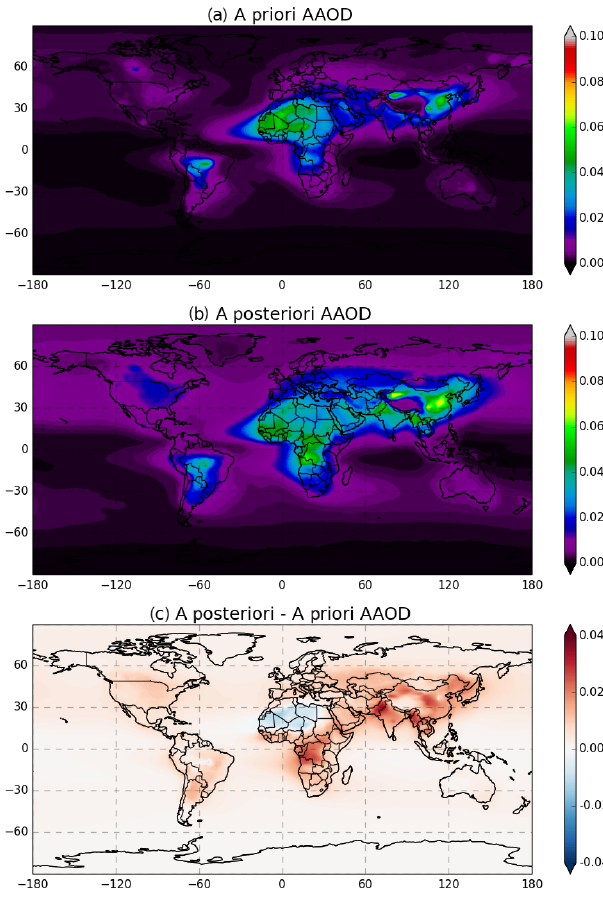
Figure 5. Same as Fig. 4 but for